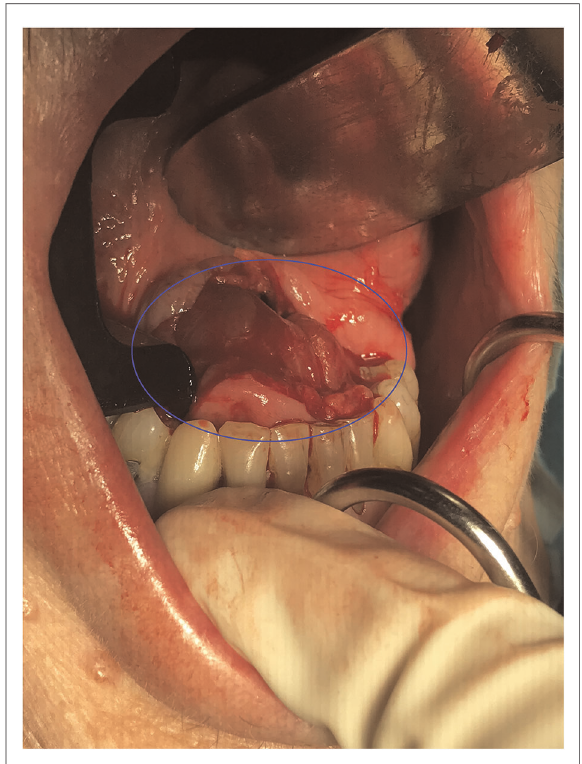
FIGURE 3 Text description: perioperative photos from the oral cavity showing an incision in the mucosa of the fl oor of mouth which gives direct contact with one of the RMs marked with a blue circle.